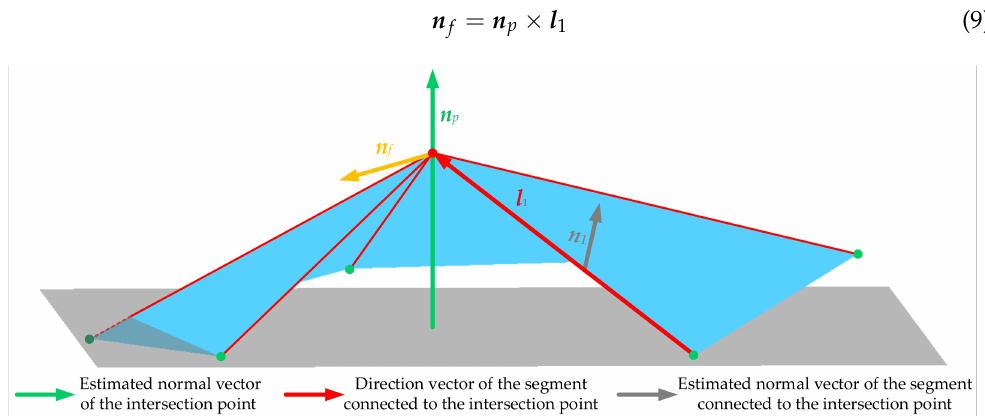
Figure 4. Normal estimation of the beginning and the end segments.